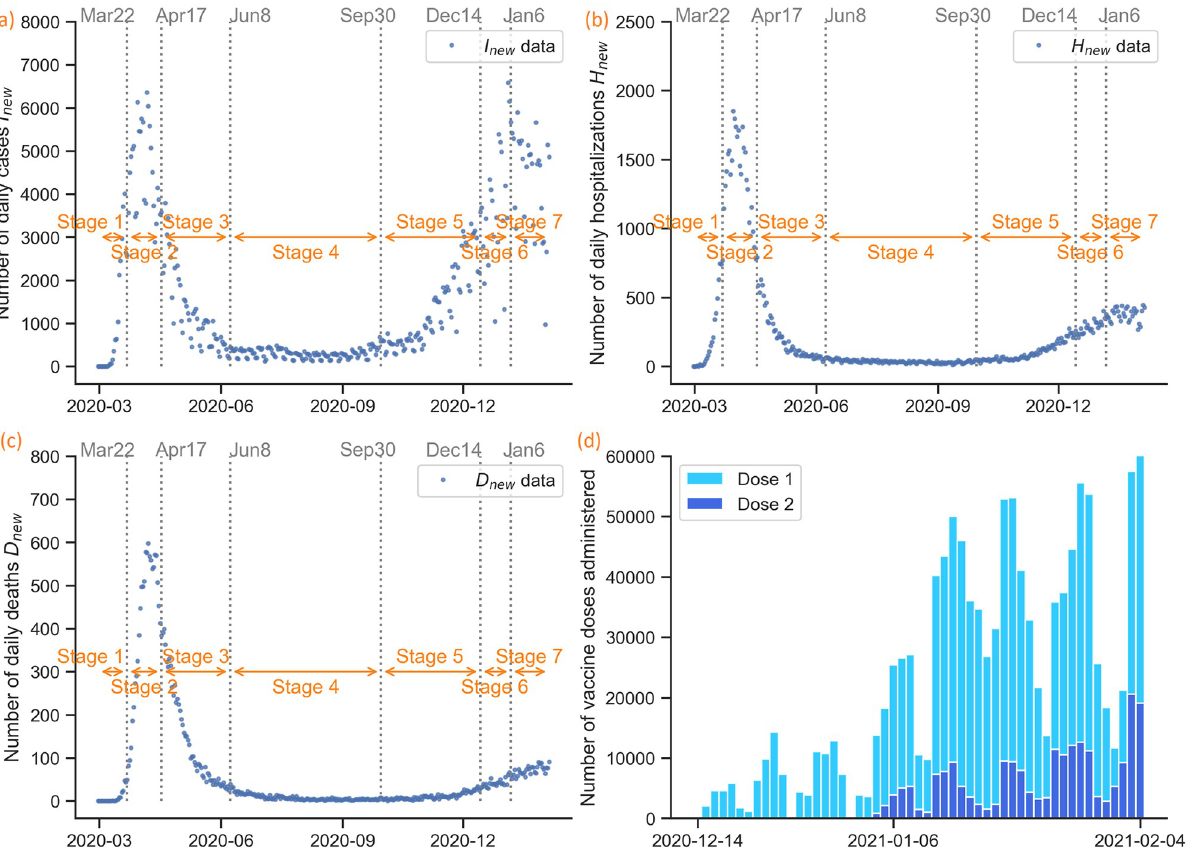
Fig 2. COVID-19 epidemic in New York City: Data and event timeline. (a) Daily confirmed cases (February 29, 2020–February 4, 2021). A person is classified as a confirmed COVID-19 case when they test positive in a molecular test (PCR). We split the data into seven time periods based on interventions implemented. The starting times of interventions are shown on the top of each subfigure. (b) Daily hospitalized population (February 29, 2020–February 4, 2021). (c) Daily deceased population. (February 29, 2020–February 4, 2021). A deceased individual is classified as a disease-related death if they had a positive PCR test for the virus within the last 60 days. (d) Daily vaccinated population. (December 14, 2020–February 4, 2021).